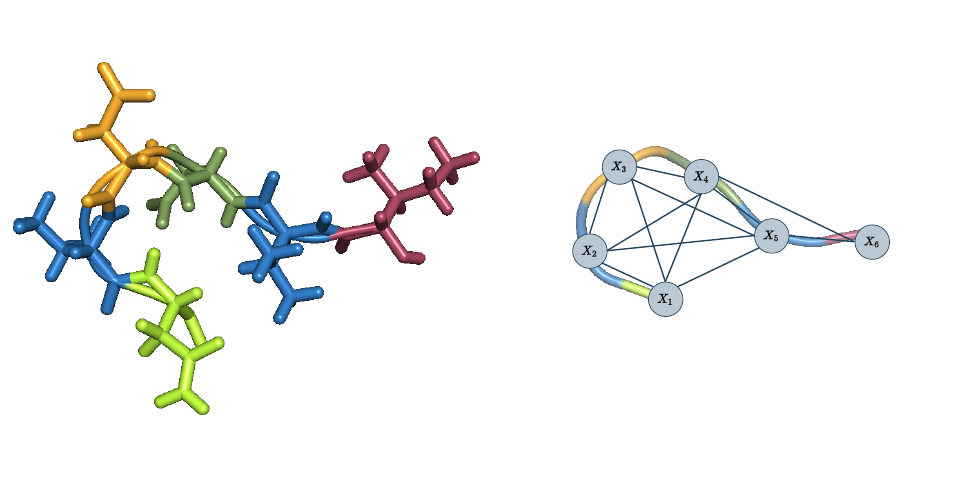
Figure 2. Input backbone and cost function network representation of a corresponding CPD instance with 6 mutable or flexible